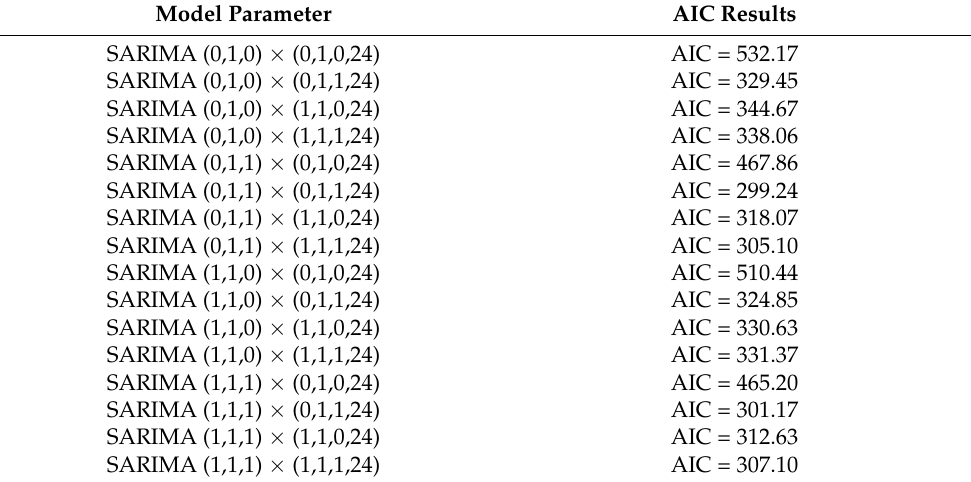
Table 4. AIC calculation results of offset